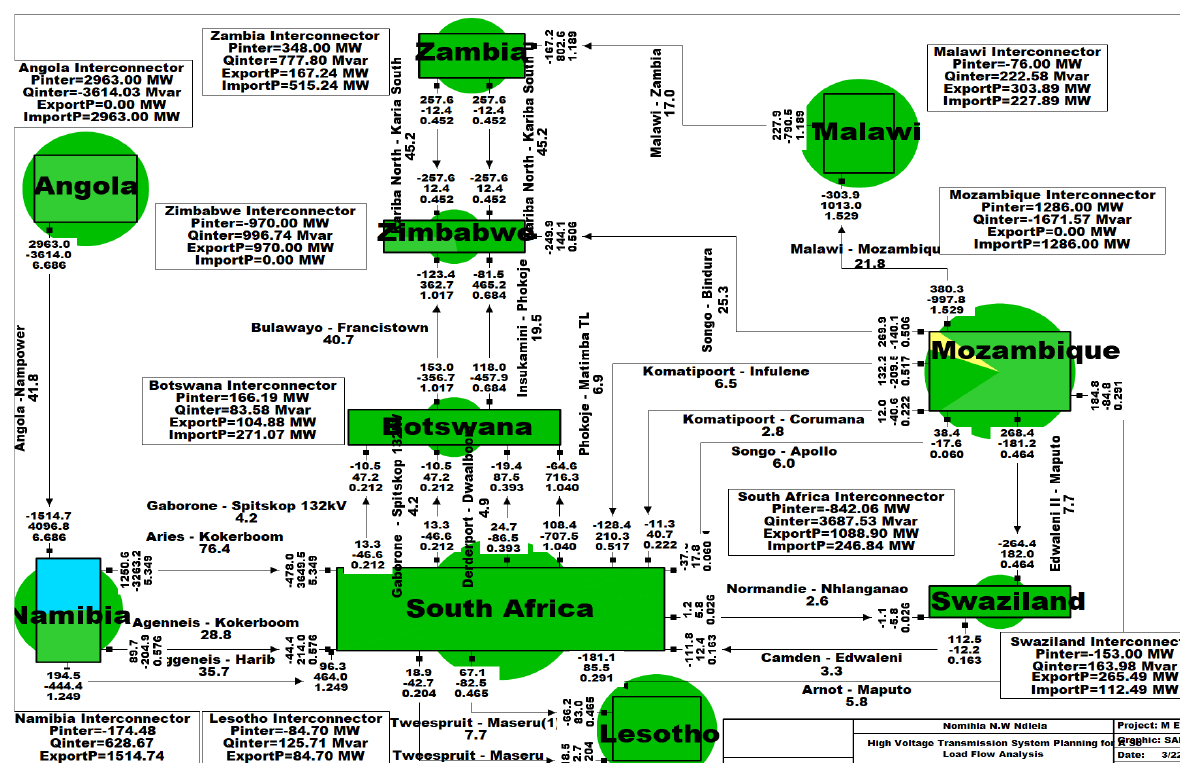
Energies 2023 , 16 , x FOR PEER REVIEW Figure 7. South Africa power system network model. Figure 7. South Africa power system network model.